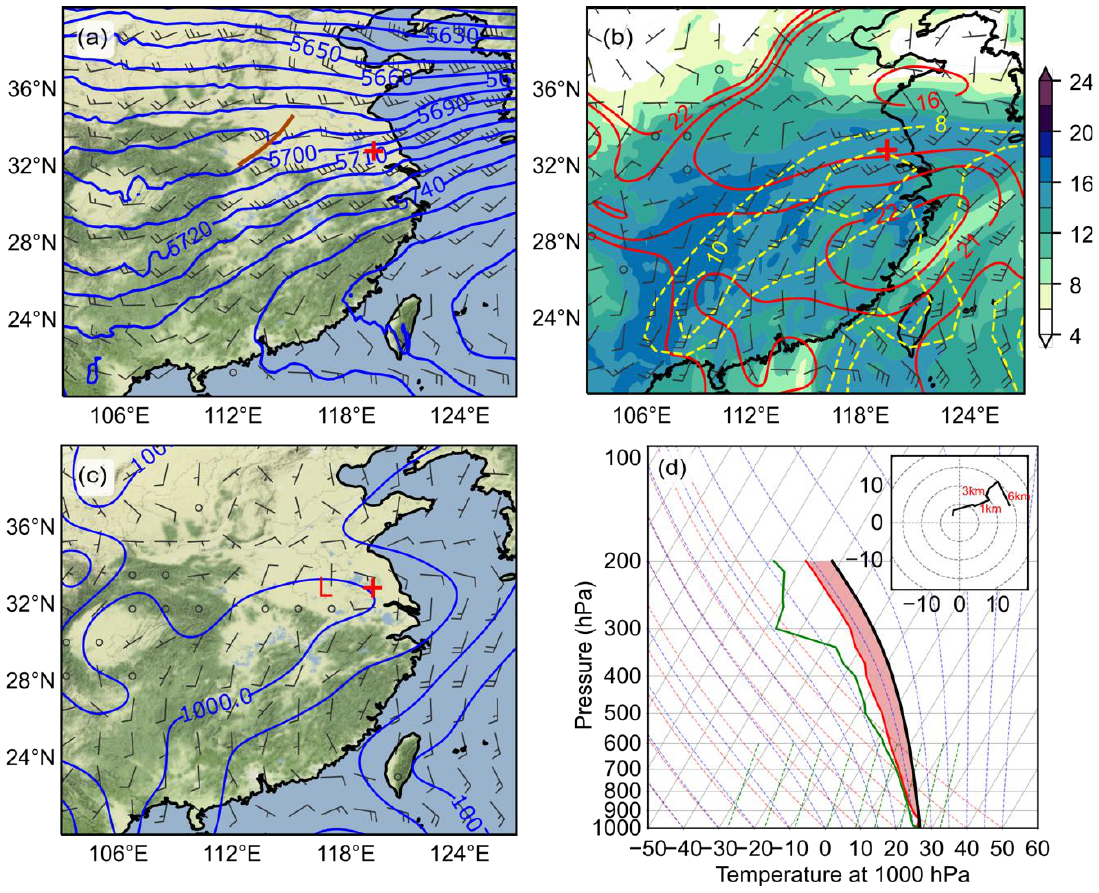
Figure 2. The weather map and the NJ sounding at 0800 LTC on 12 June 2020. ( a ) Geopotential heights at 500 hPa (the blue contours; gpm), the winds (barbs; m s −1 ). The brown line shows the weak trough. ( b ) The winds (barbs; m s −1 ), temper- ature (the red contours; ℃ ), and the specific humidity (shaded; g kg −1 ) at 850 hPa . The southwest jets (>8 m s −1 ) are marked by yellow contours. ( c ) Mean sea level pressure (the blue contours; hPa) and the 10 m AGL winds (barbs; m s −1 ), the “L” marks the location of the low -pressure system. ( d ) The NJ sounding plotted on a skew T- log P diagram. The tem- perature 𝑇 (dewpoint 𝑇 𝑑 ) in ℃ is shown as the red (green) line. The black line shows the ascending path of a surface- based parcel. The square box in the upper-right corner shows the 0 – 6 km hodograph with winds in m s −1 . Half barbs and full barbs in ( a – c ) denote 2.5 and 5 m s −1 , respectively. The red crosses in ( a – c ) represent the tornado location.